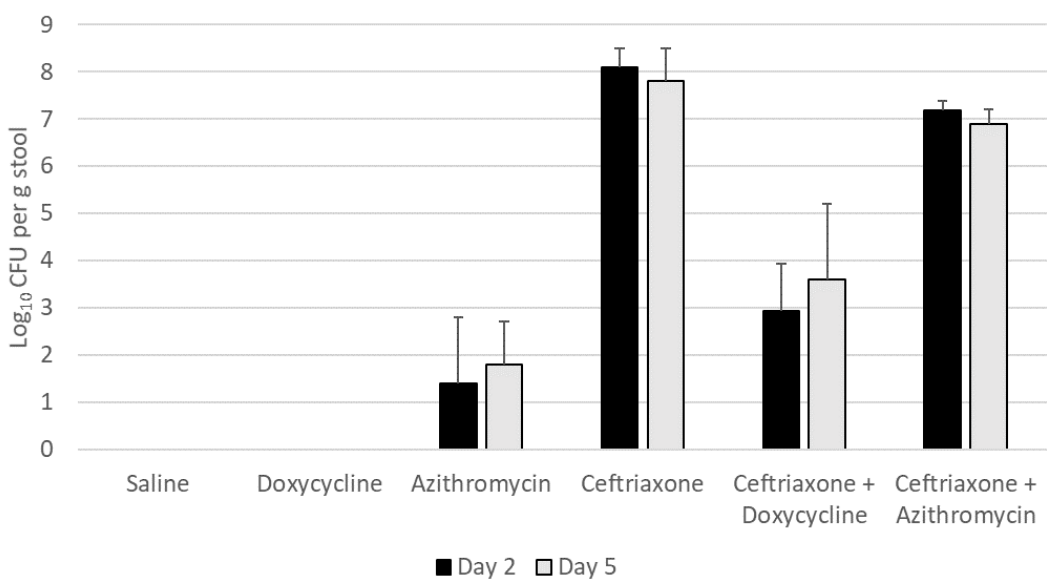
Figure 1B. Doxycycline-resistant Clostridioides difficile (strain 368)